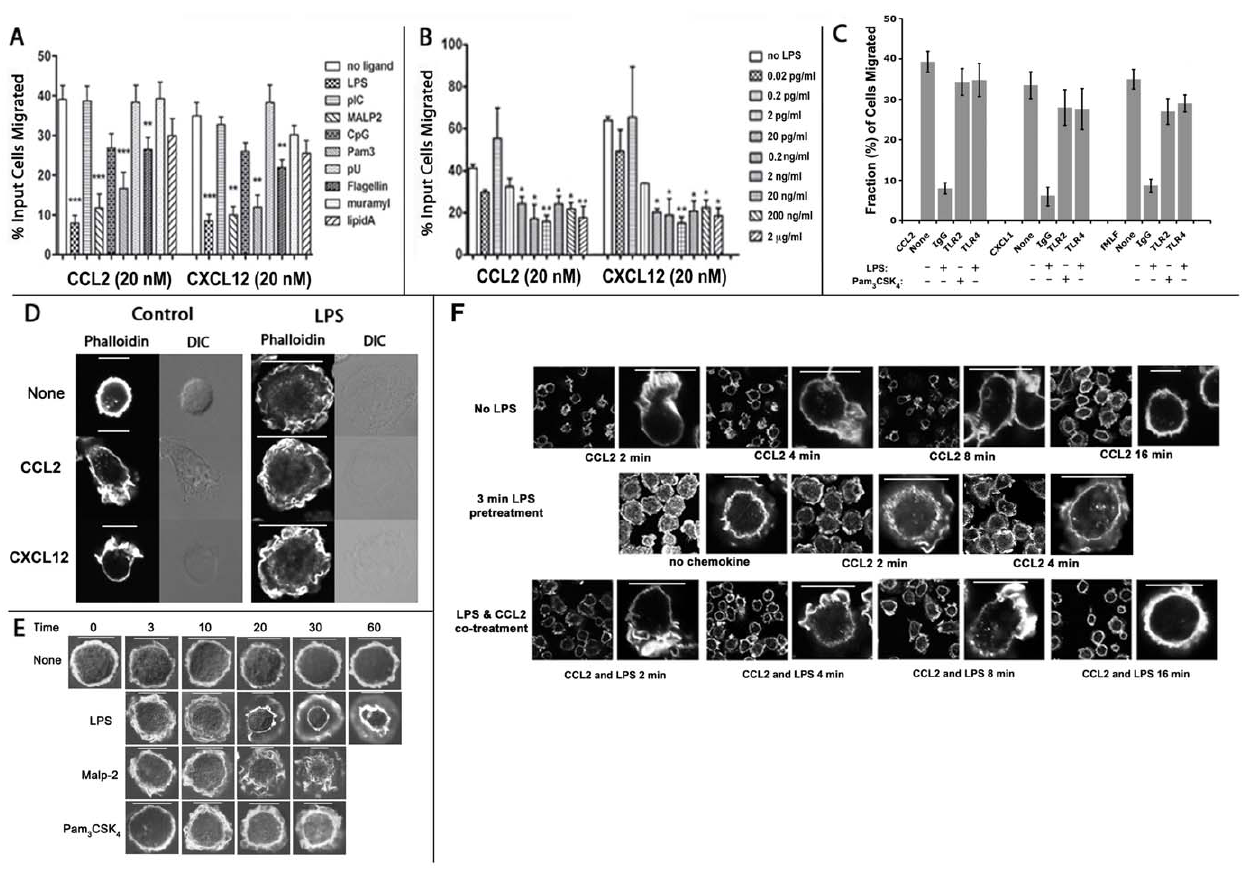
Figure 1. LPS treated human monocytes displayed flattened morphology and are inhibited for chemotaxis. A ) Relative chemotactic inhibition by different TLR ligands. Primary human monocytes were treated with the indicated TLR ligands exactly as described under Methods and allowed to migrate towards 20 nM CCL2 or CXCL12 in the Trans-well chamber. Data are plotted as histograms with error bars (n=3; **, p , 0.03; ***, p , 0.01). B ) LPS dose response of chemotactic inhibition of monocytes. Monocytes (5 6 10 5 ) were pretreated for 15 min with the various concentrations of LPS, washed 3 X and placed in the upper wells of 5.0 m m Trans-well and allowed to migrate towards 20 nM CCL2 or CXCL12 in the bottom wells. Relative fraction (%) of input cells that migrated to the bottom well is plotted in the histogram with error bar (n=3; *, p , 0.03,